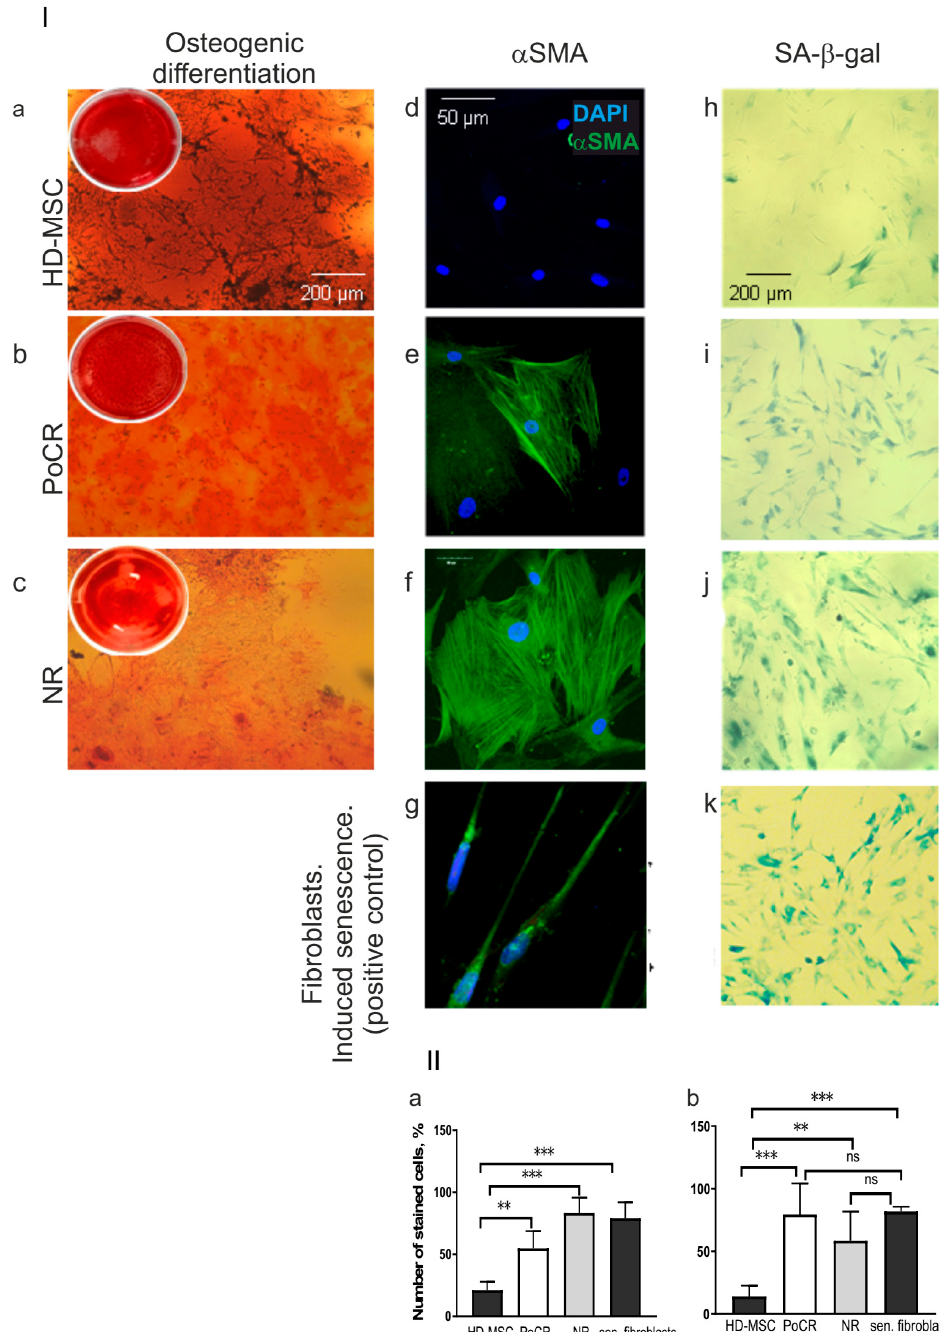
Figure 4. Osteogenic potential ( a – c ), TME markers ( d – k ), in HD-MSC ( a , d , h ), PoCR MSC ( b , e , i ), and NR-MSC ( c , f , j ). Fibroblasts with the drug-induced senescence were used as a positive control ( g , k ). Panel I: ( a , b , c ) Calcifications revealed by staining with Alizarin Red, insets in upper left corners of each image represent a general view of a plate well; ( d – g ) staining with an antibody against α SMA (green), nuclei are counterstained with DAPI; ( h – k ) activated SA- β -gal staining; nuclei are counterstained with DAPI. The scale bars for each panel are shown in the images. Panel II: The results of staining quantification: number of cells stained with ( a ) an anti α SMA antibody or ( b ) with a dye revealing activated SA- β -gal is plotted on the Y-axis. ** p < 0.01, *** p < 0.001, ns = non-significant ( p > 0.05). Abbreviations: DAPI = 4’,6-diamidino-2-phenylindole; HD-MSC = mesenchymal stromal cells from healthy donors; HS2/HS3 = human satellite 2,3; MSC = mesenchymal stromal cells; NR = non-responder; PoCR = partial or complete response; SA- β -gal = senescence-associated β -galactosidase; TME = tumor microenvironment; α SMA = α -smooth muscle actin,.